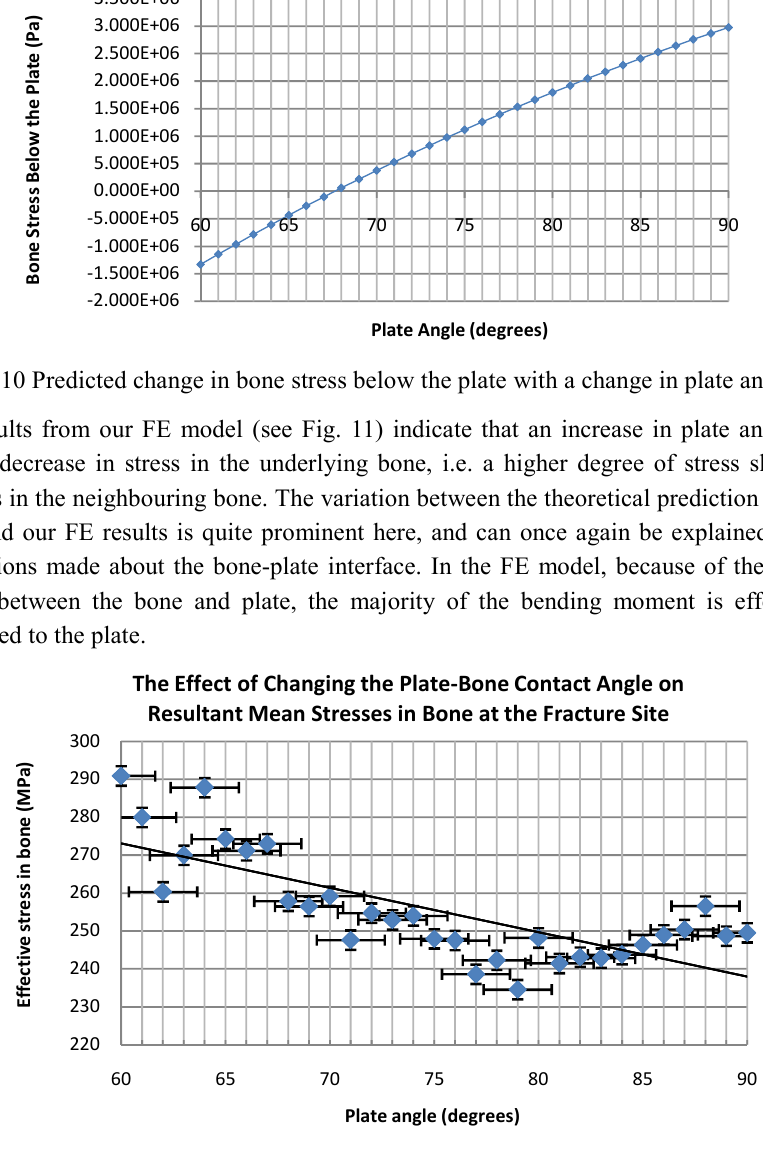
Fig.11 A decrease in effective stress in the bone at the bone-plate interface occurs with an increase in plate-bone contact